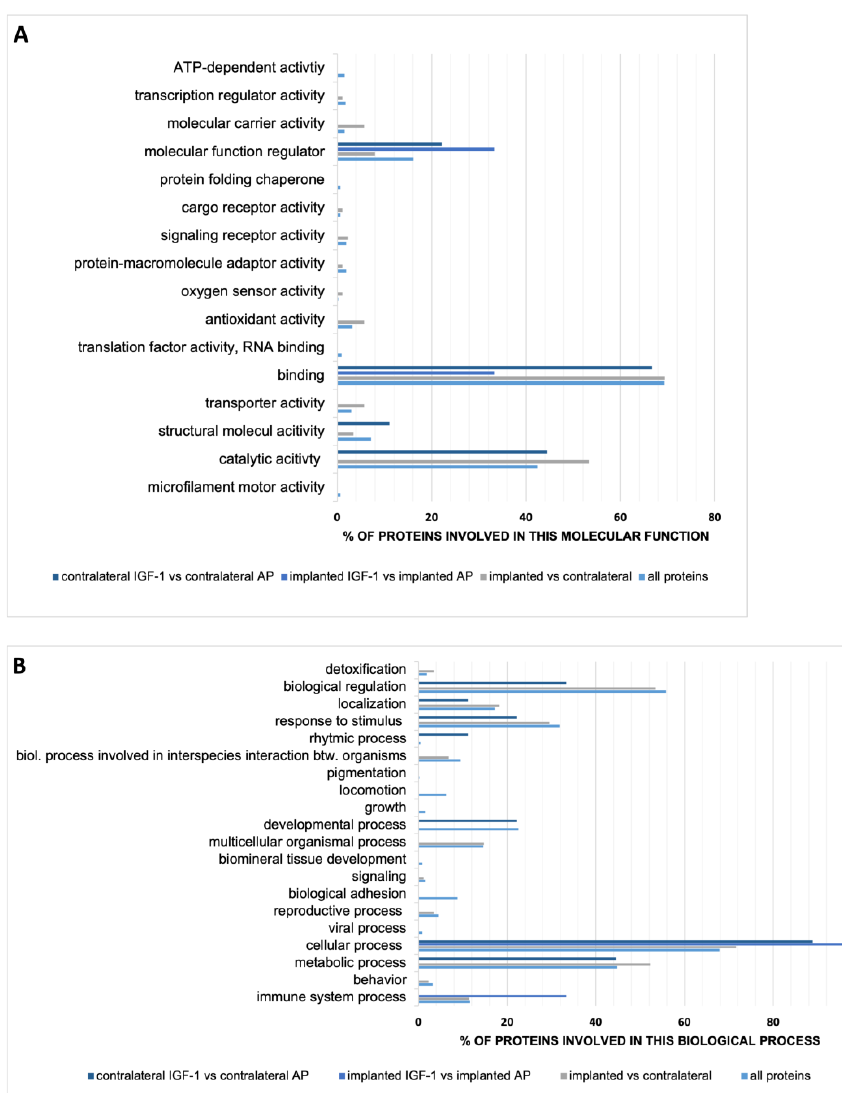
Figure 6. Characterization of guinea pig perilymph proteins by GO profiles by ( A ) molecular function and ( B ) biological process. Categories are counted nonexclusively, so a protein may count in more than one category. The total number of proteins varies per group. All proteins display the 466 quantified proteins. The other groups display only significant varied proteins, which are 88 for the comparison implanted (both IGF-1 and AP) vs. contralateral ears, 3 for the comparison implanted with IGF-1 vs. implanted with AP and 9 for the comparison of the contralateral ears of both treatment group. Accordingly, the counts mapped to the categories molecular function and biological process vary in number and were used as 100% value. Therefore, the counts are standardized and illustrated in %.